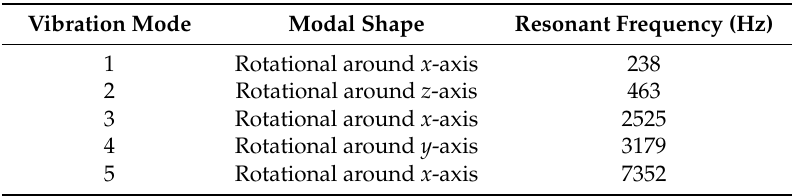
Table 3. Simulated vibration modes of the microgripper obtained by FEM.